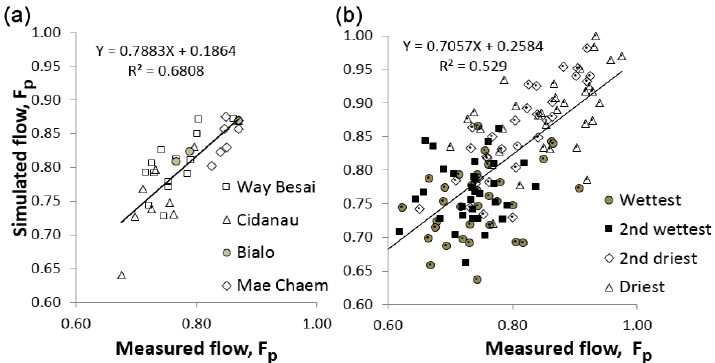
Figure 3. Inter- (a) and intra-annual (b) variation in the F p parameter derived from empirical vs. modelled flow: for the four test sites on annual basis (a) or 3-monthly basis (b)